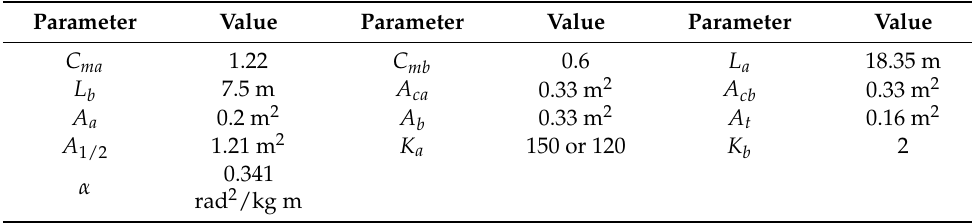
Table 1. Parameters of the hydrodynamic